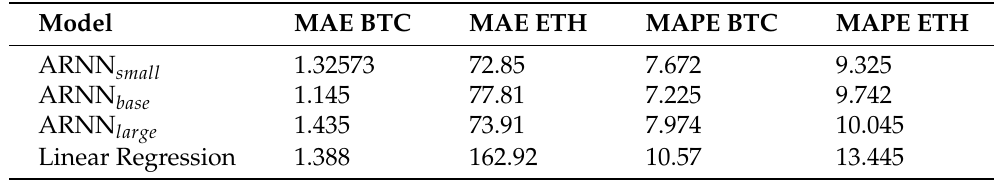
Table 2. Comparison MAE and MAPE